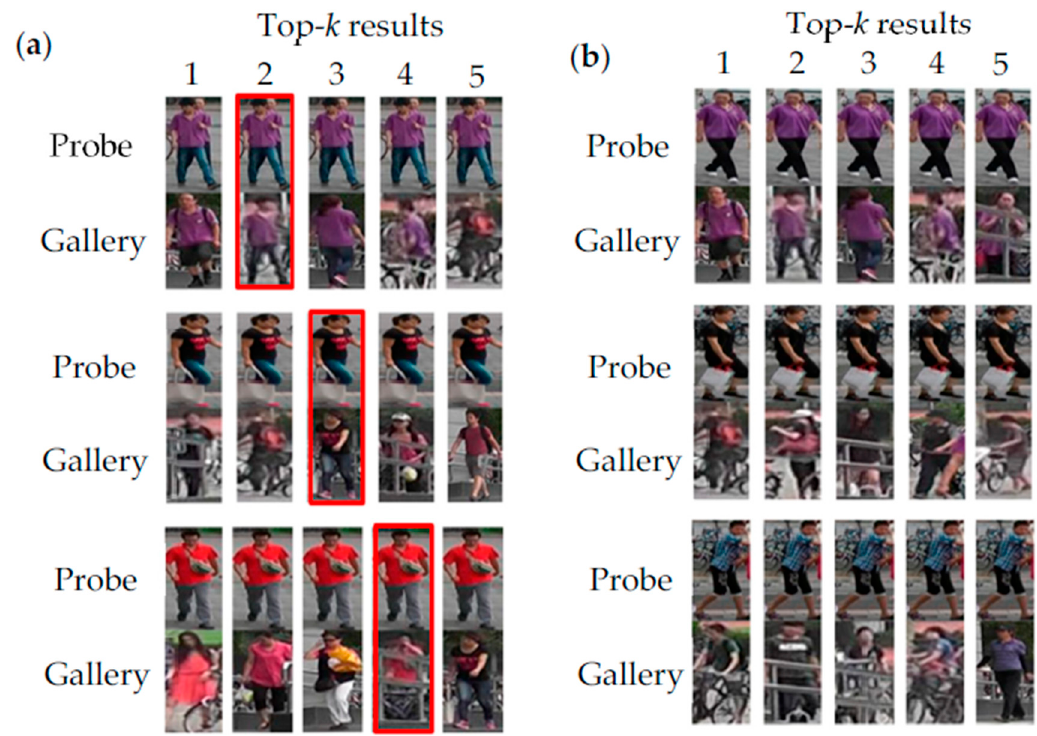
Figure 8. Examples of the identification results in Experiment 2 (identification network): ( a ) successful and ( b ) failure cases.